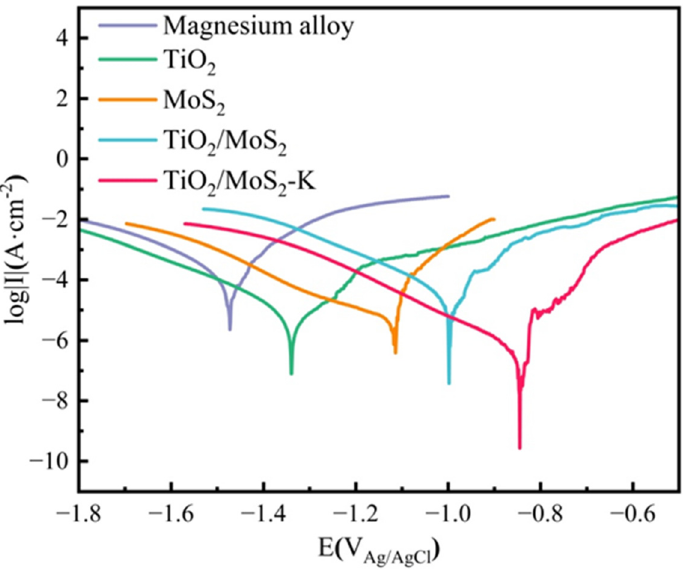
Figure 6. Polarization curves of magnesium alloy, TiO 2 , MoS 2 , TiO 2 /MoS 2 , TiO 2 /MoS 2 -K. Table 2. Potentiodynamic polarization curves of samples in 3.5 wt % NaCl aqueous solution.